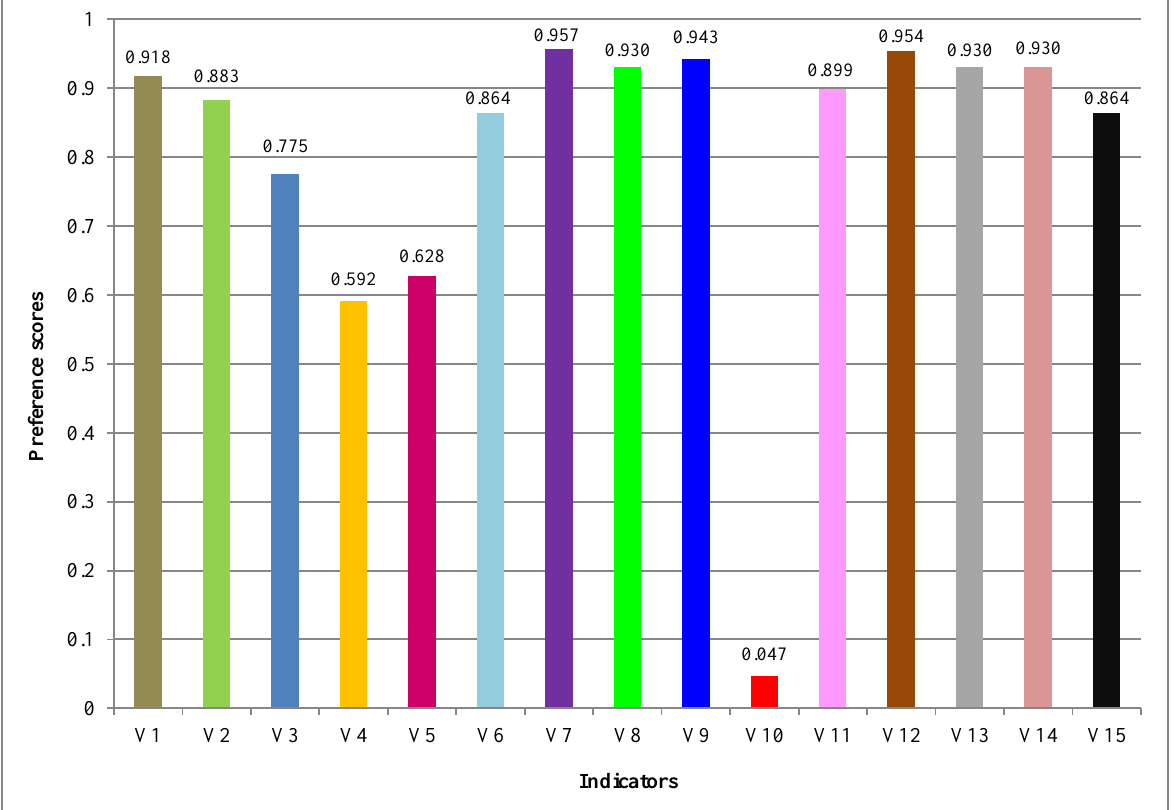
Figure 4. Recapitulation of preference scores for each evaluation